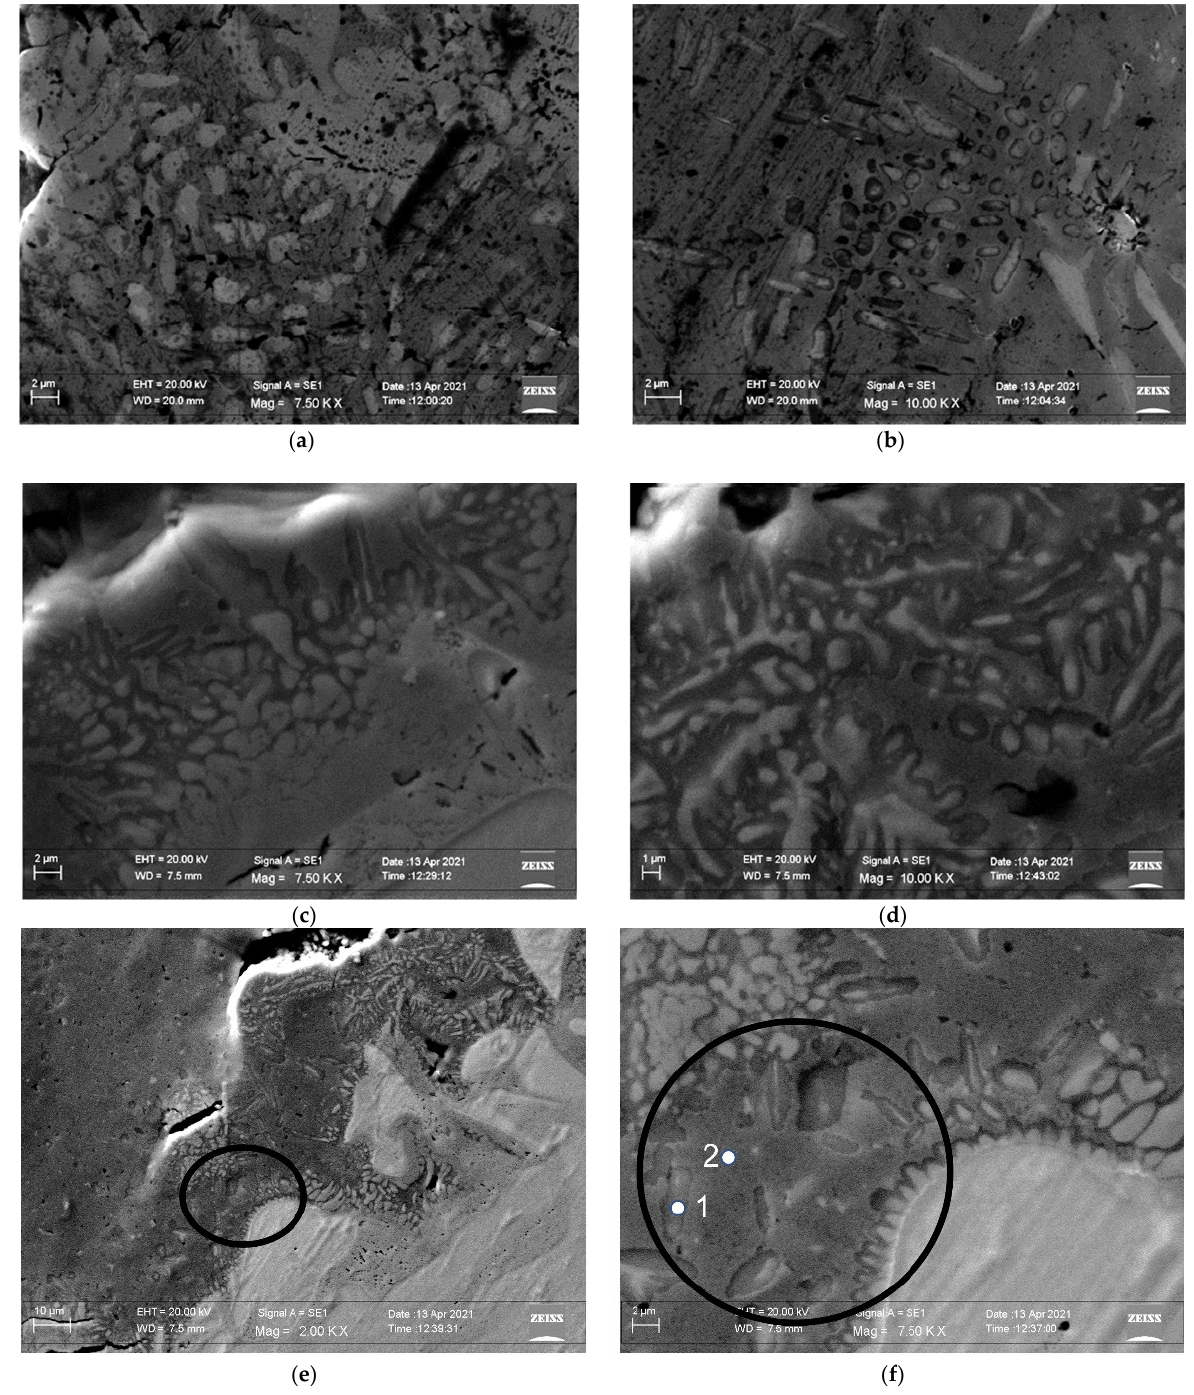
Figure 14. Scanning electron micrographs before ( a , b ) and after ( c , d ) SRHT for 3T weld at 7500 × ( a , c ) and 10,000 × ( b , d ). 3T sample microstructure after SRHT at 2000 × and 7500 × with circled the zone of EDS investigation ( e , f ), together with the points of analysis ( f ).